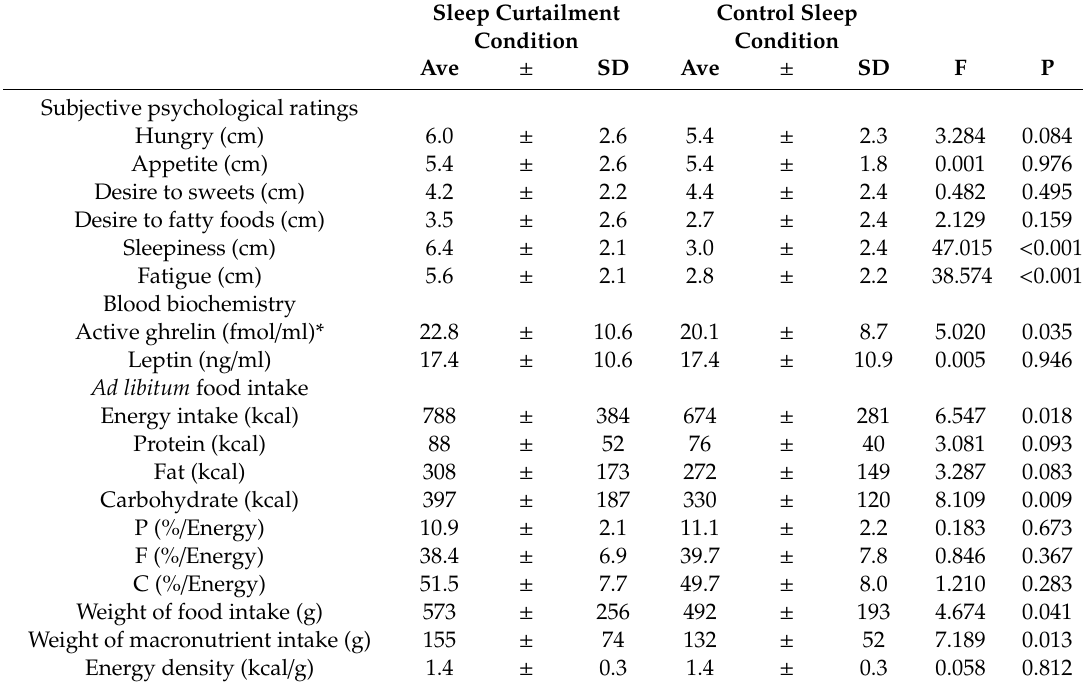
Table 3. Subjective psychological ratings, active ghrelin level, leptin level, and Ad libitum food intake at breakfast of participants in the sleep curtailment and control sleep conditions.